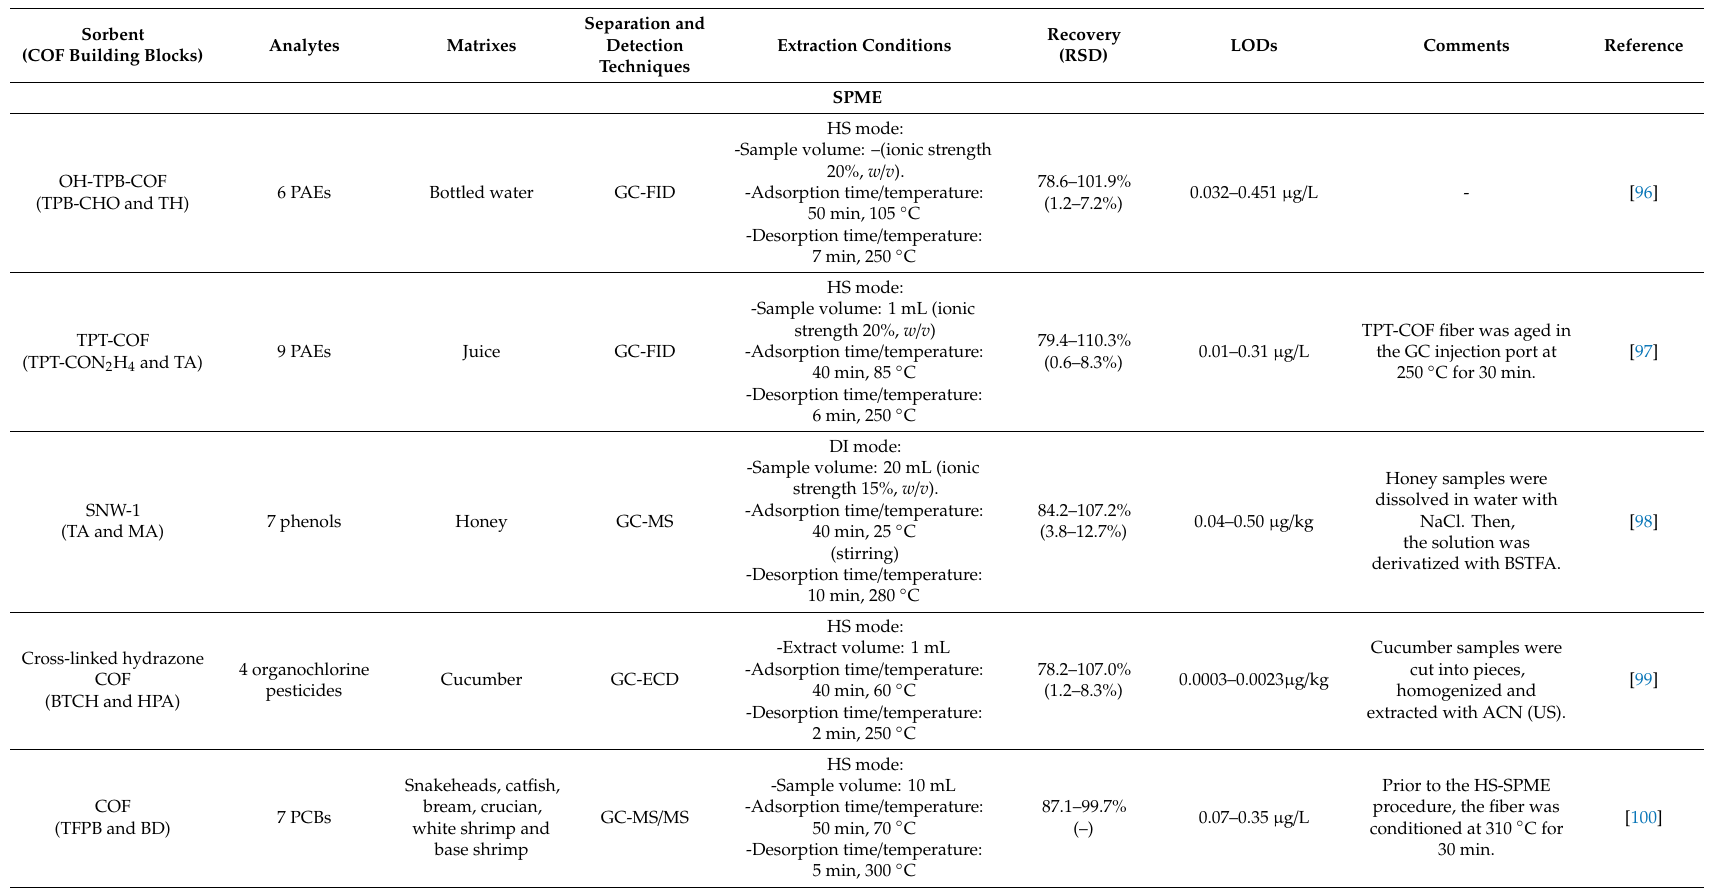
Table 3. COFs’ applications as sorbents in SPME and